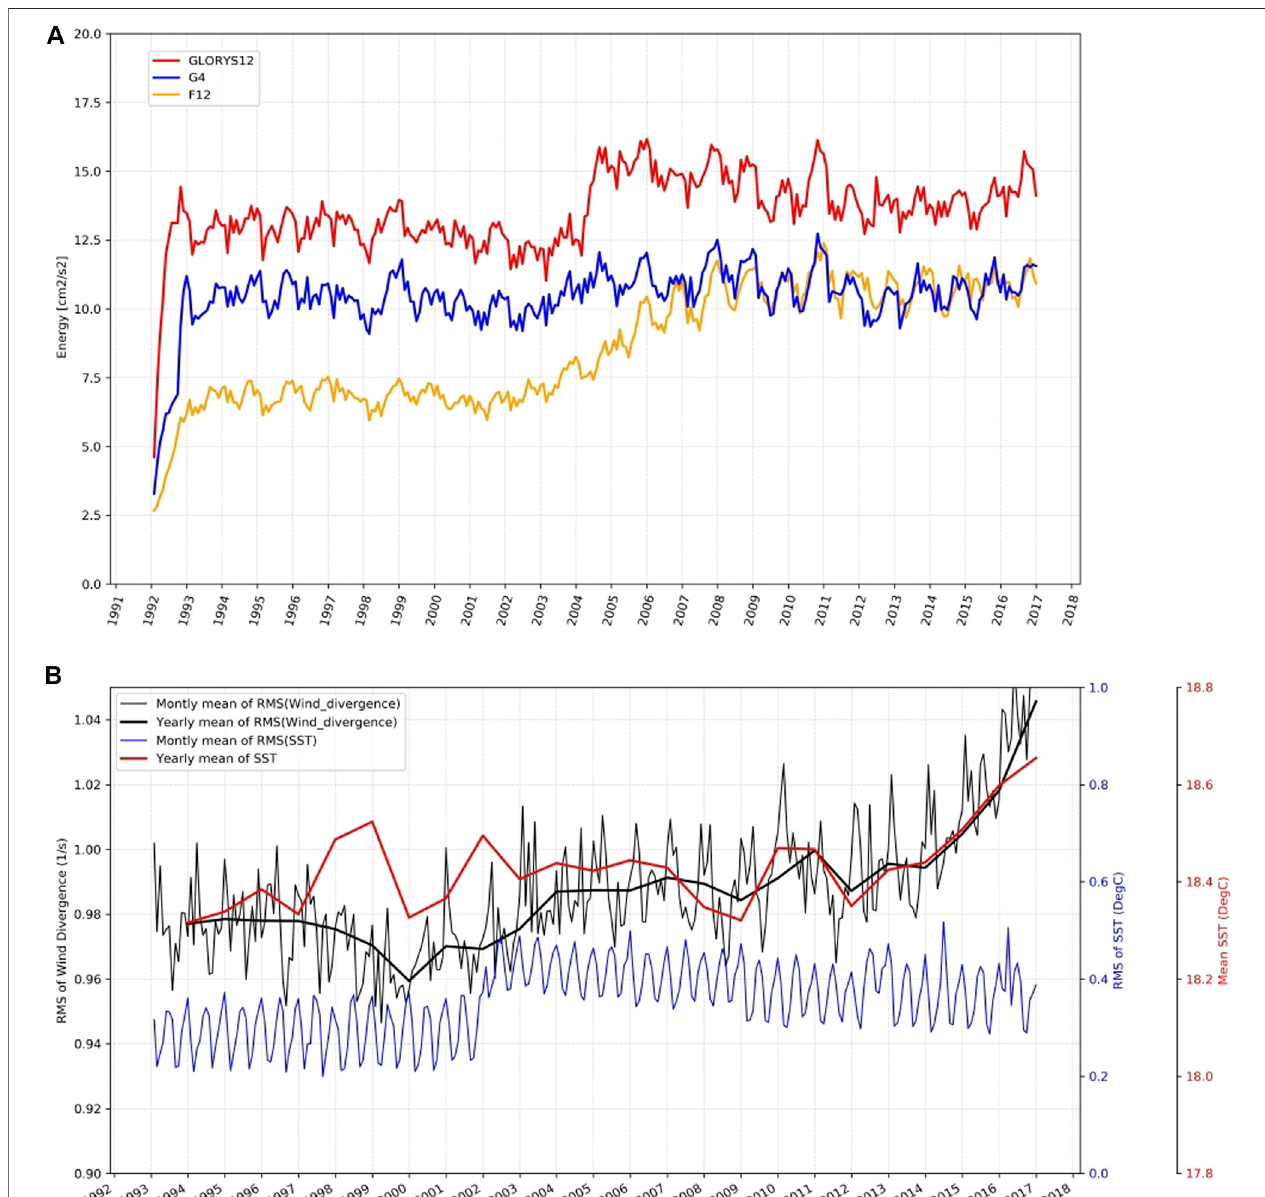
FIGURE 12 | (A) Three-dimensional mean of monthly Eddy Kinetic Energy (in cm 2 /s 2 ) for GLORYS12 (in red), F12 (in orange), G4 (in blue). (B) Monthly mean of spatial variance of daily SST (in blue), monthly (thin black) and yearly (thick black) mean of spatial variance of daily wind divergence, and yearly mean of SST (in red).